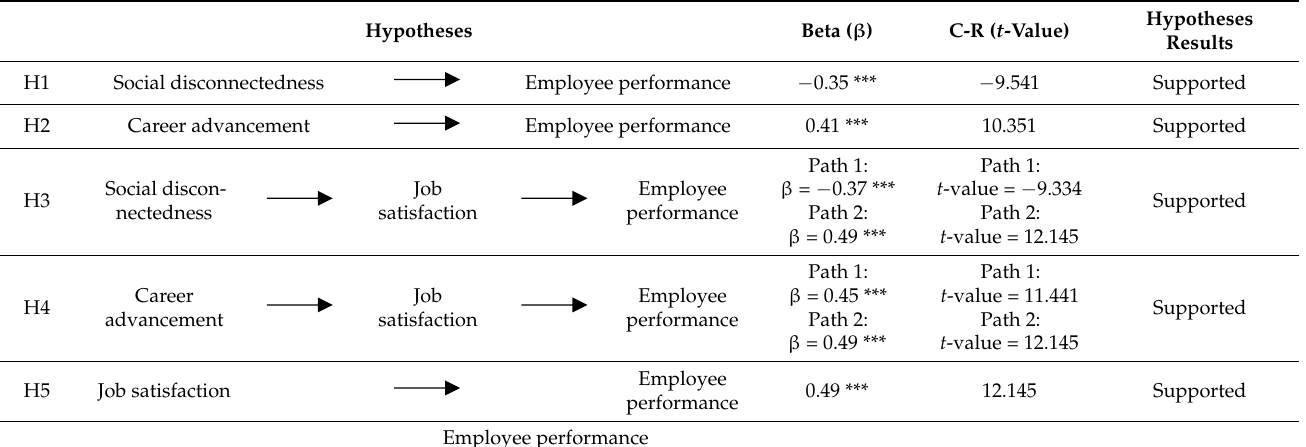
Table 4. The structural model results.